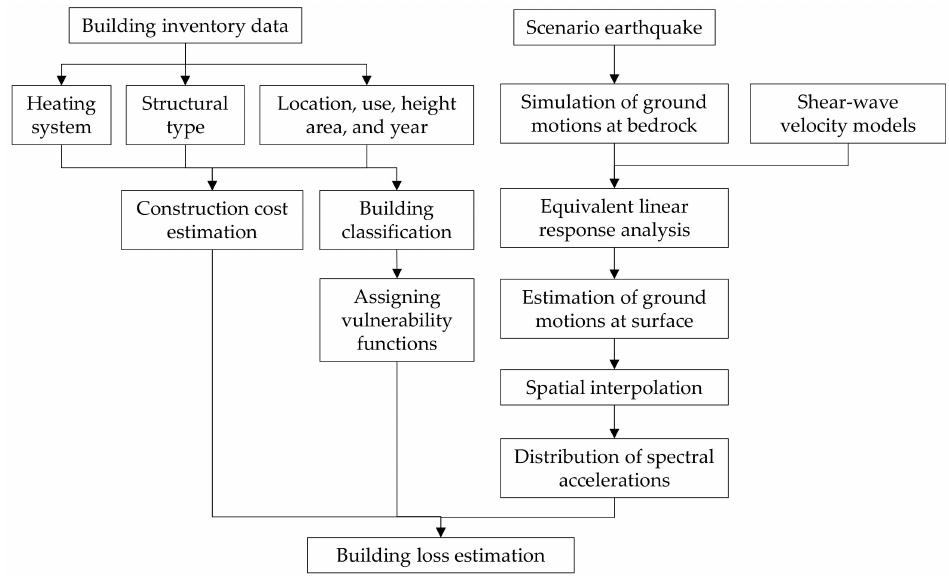
Figure 1. Flowchart for construction cost estimation from building inventory data and building loss estimation due to a scenario earthquake.